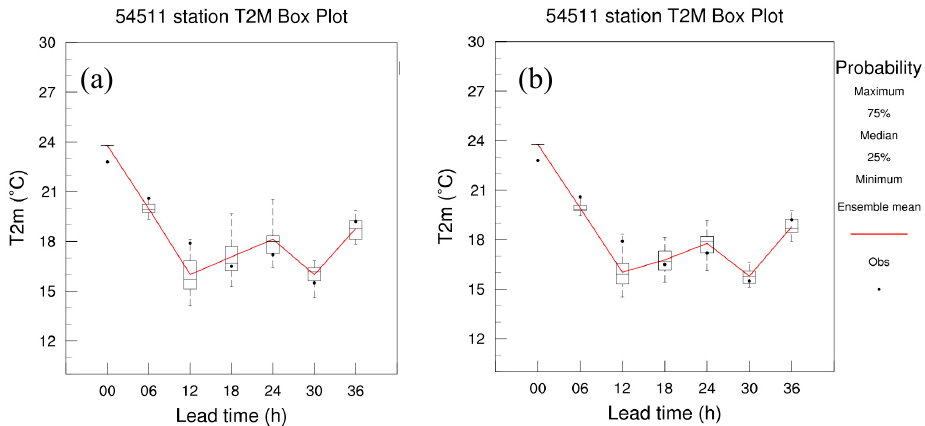
Figure 7. Box plot of the 2 m temperature forecast at a Beijing station for the two schemes. ( a ) Down and ( b ) Breeding;.